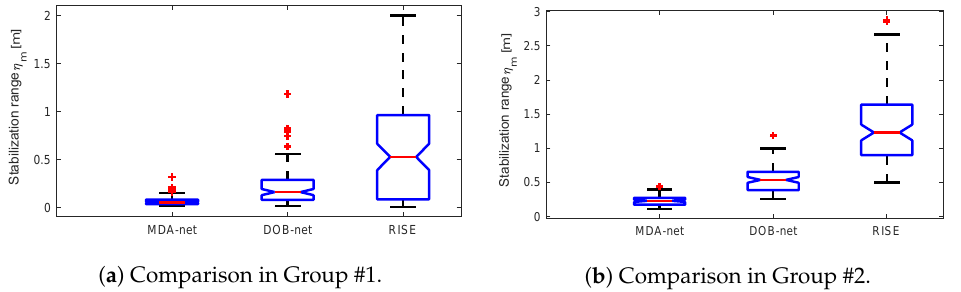
Figure 7. Comparison among MDA–net, DOB–net, and RISE under disturbances in Groups #1 and